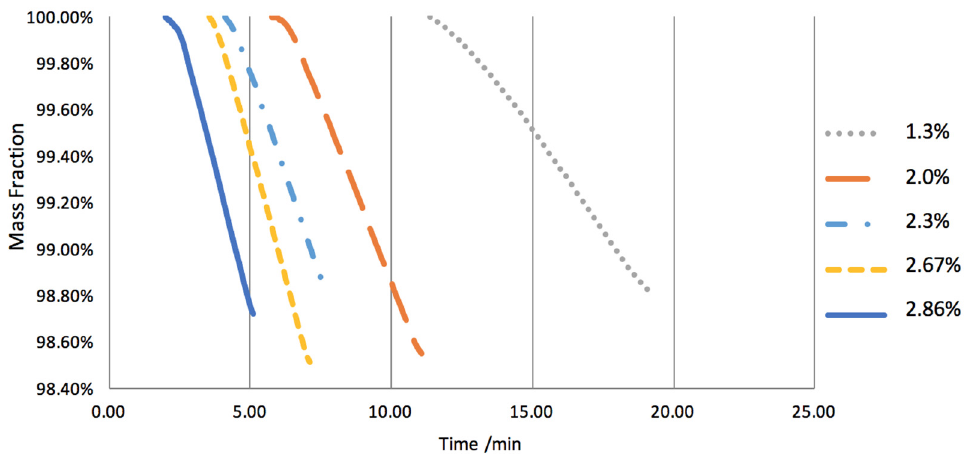
Figure 7. TGA results of RuO x reduction on 50 mg 5% Ru/Al 2 O 3 powder samples H 2 partial pressures from 1.3% to 2.86% at 300 °C. Only reduction sections are shown in the figure.